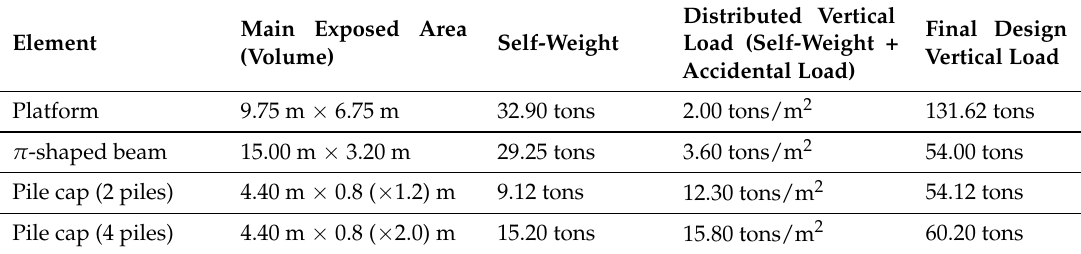
Figure 3. Beach profiles at Pont del Petroli. The original beach profile from the design report is indicated by a blue line. In red, the two profiles surveyed by LIM/UPC before and after storm Gloria. Table 1. Main characteristics of the Pont del Petroli pier